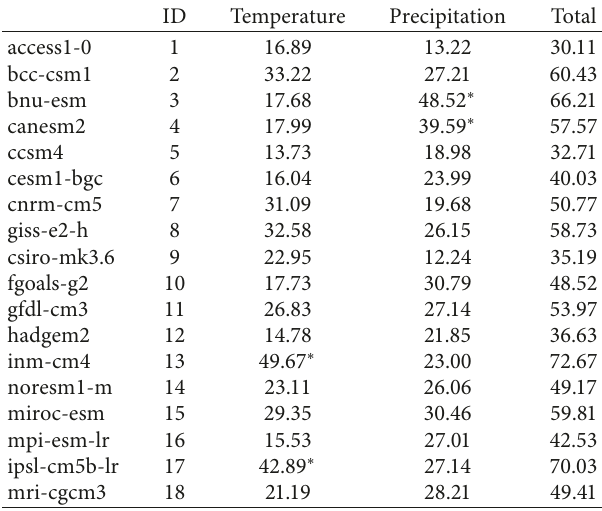
Table 4: The scores of the GCMs for monthly temperature and